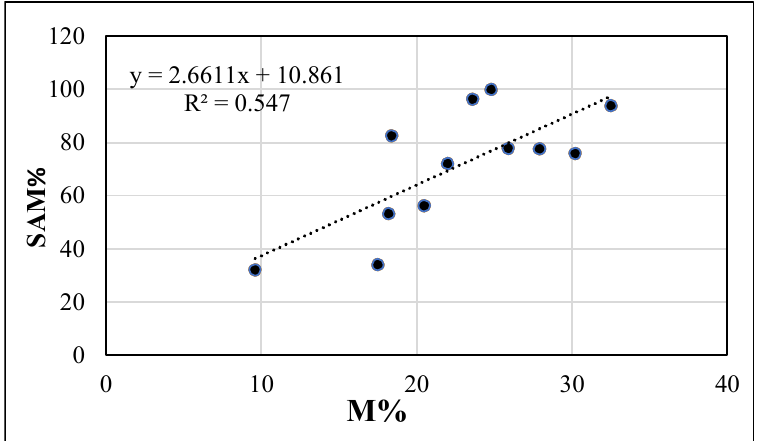
Figure 3. Regression models and R 2 of mycorrhizal colonization intensity (M, in %) vs. frequency of the “Supporting Arbuscular Mycorrhiza” weed species (SAM, in %) in melon systems (No ASC and Yes ASC). Data are refer August 2014 sampling (at melon n harvest, N = 15).